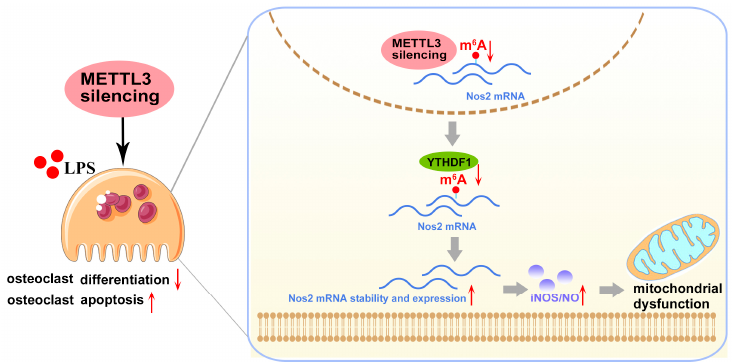
Figure 8. Mode pattern. METTL3 regulates osteoclast biological behaviors via iNOS/NO-mediated mitochondrial dysfunction in inflammatory conditions. METTL3 knockdown reduces YTHDF1-me- diated Nos2 mRNA degradation and promotes mRNA stability and expression of Nos2 , which ag- gravates iNOS/NO-mediated mitochondrial dysfunction and, consequently, inhibits osteoclast dif- ferentiation and accelerates osteoclast apoptosis in inflammatory conditions. The red upward ar- rows mean upregulation; the red downward arrows mean downregulation.